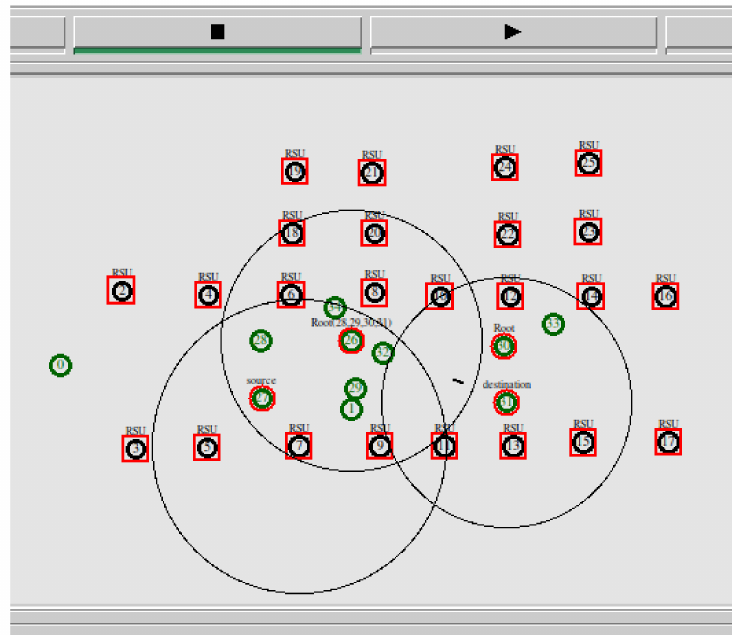
Figure 6. Source node starts sending